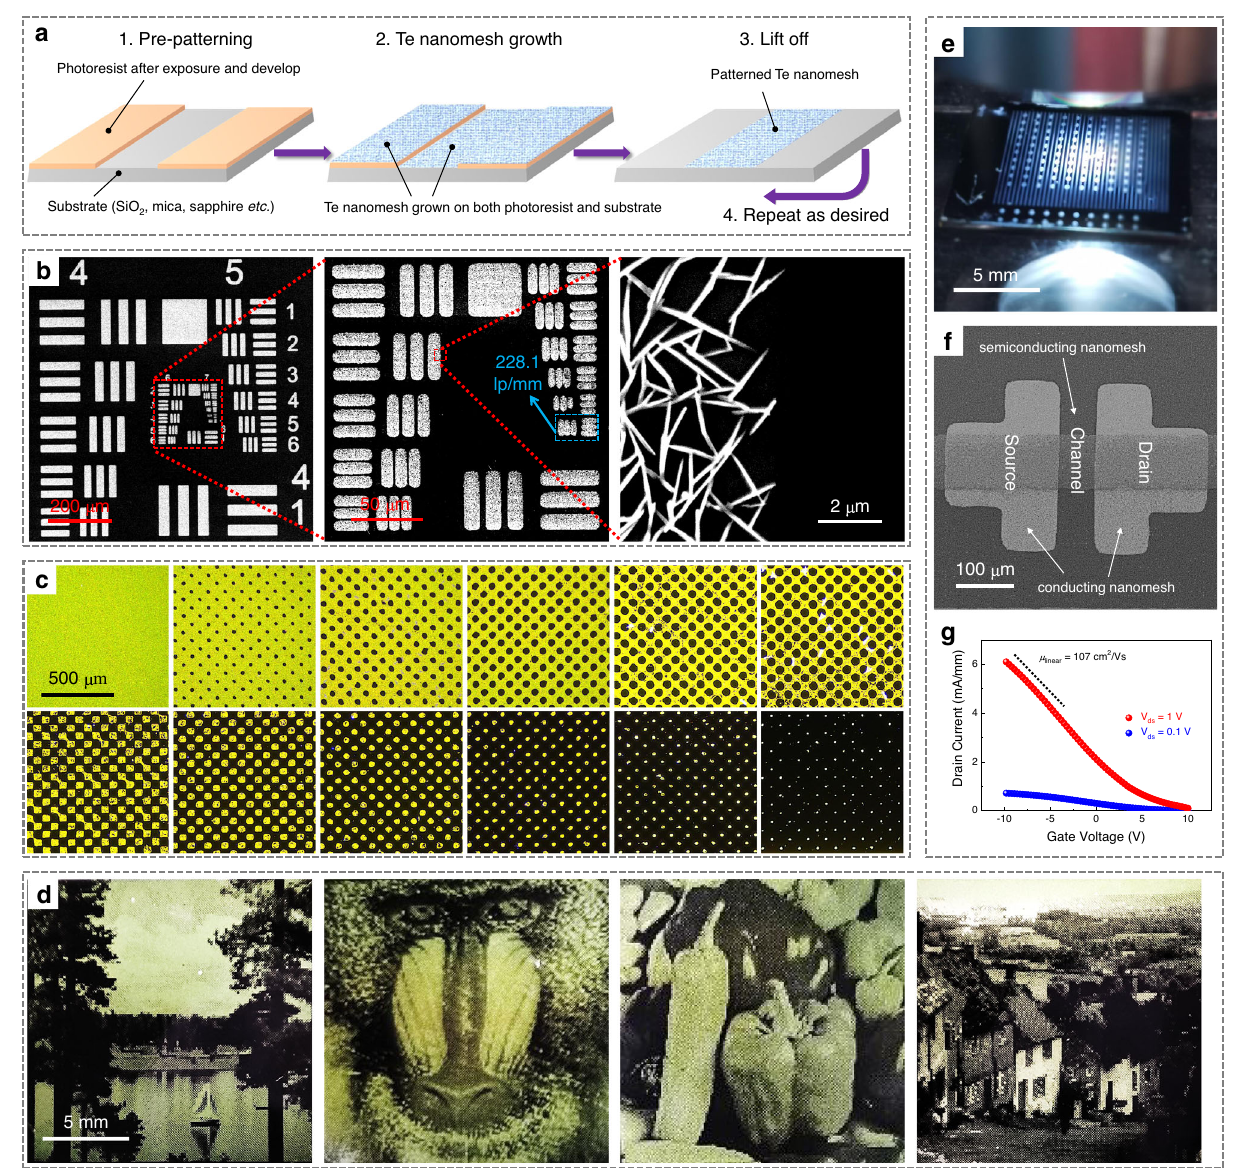
Fig. 5 | Nanomesh patterning process. a Schematic illustrations of the Te nano- mesh patterning process. b SEM images of patterned nanomeshes in USAF 1951 resolution test. Red dashed lines indicate the enlarged position. The light blue arrowshowsamaximumpatterningresolutionof228.1linepairspermillimeter(lp/